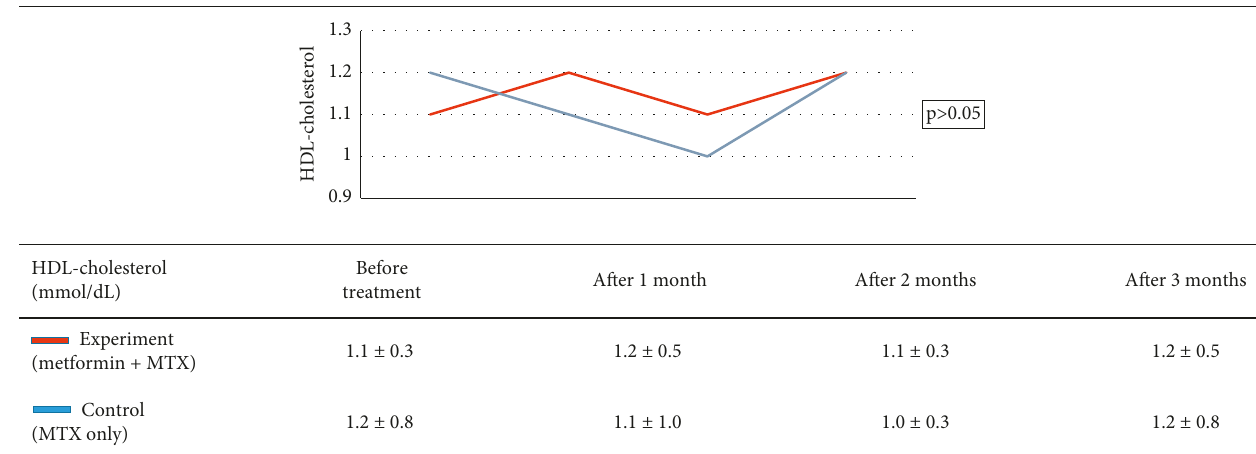
Table 9: Comparison of treatment results of two groups according to the HDL cholesterol